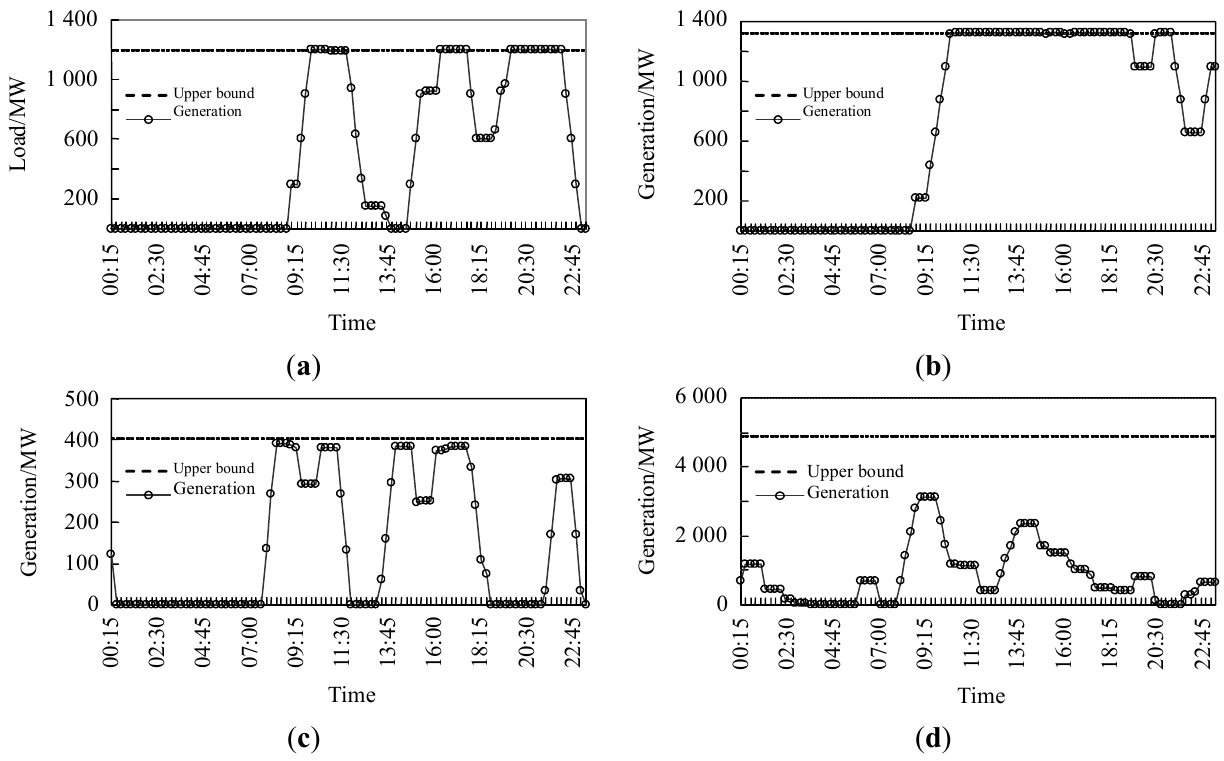
Figure 10. Optimal results for cascaded hydropower plants on Hongshui River: ( a ) Guangxi Power Grid (GXPG); and ( b ) Guangdong Power Grid (GDPG).